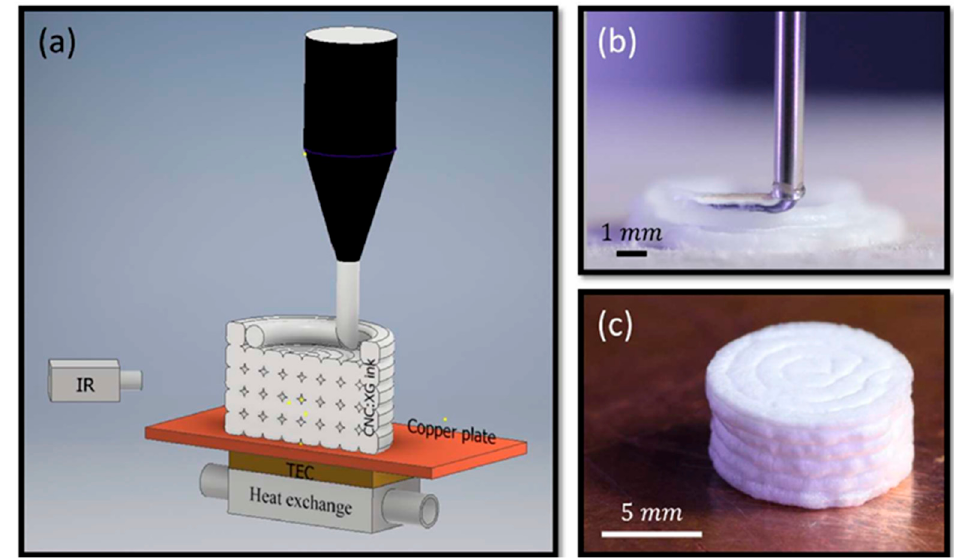
Figure 8. ( a ) Schematic illustration of the DCW setup; ( b ) photograph of the DCW printing process; and ( c ) photograph of the final aerogel [120].